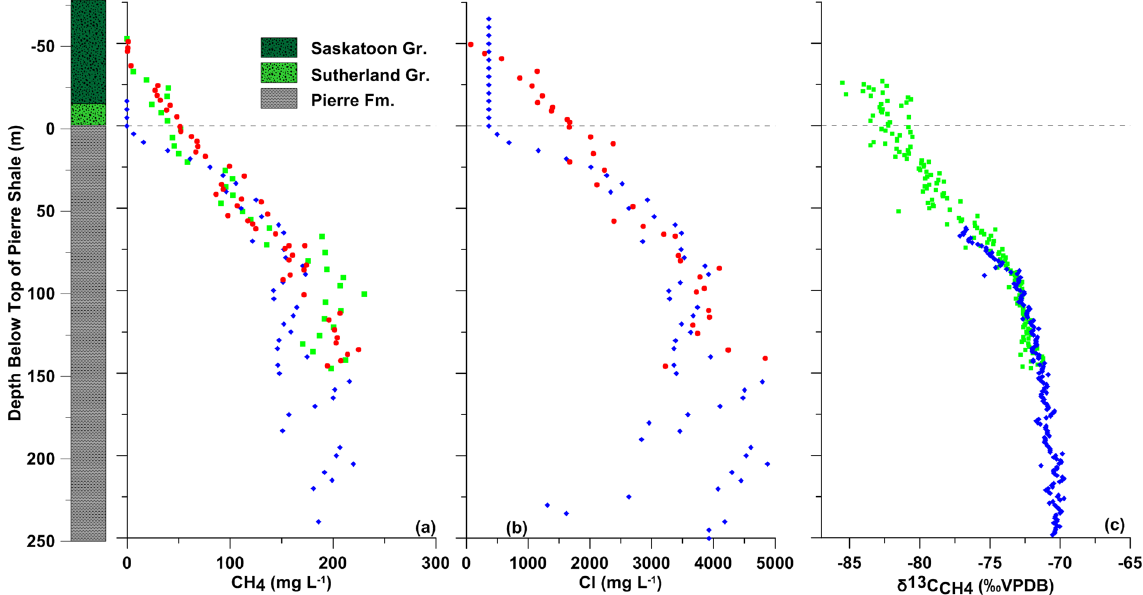
Figure 3. Geology (Site 5) and dissolved CH 4 concentrations ( a ), Cl − concentrations ( b ), and δ 13 C-CH 4 values ( c ) vs. depth below the top of the Pierre Shale at Site 5. Site 6 data from Fig. 2 are added in this figure to show the different CH 4 and Cl − profiles at Site 5 versus Sites 2 and 6. The Isojar ® data from Site 5 are shown as solid red dots, and mud gas data from Sites 5 and 6 as solid green squares and solid blue triangles,